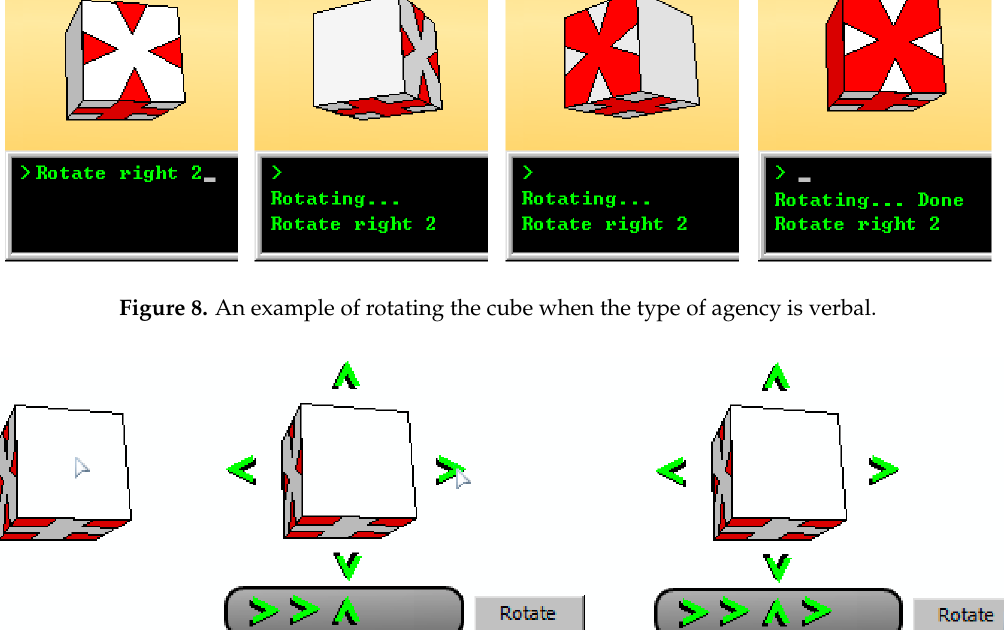
Figure 10. An example of the cube rotating with the distributed type of transition.